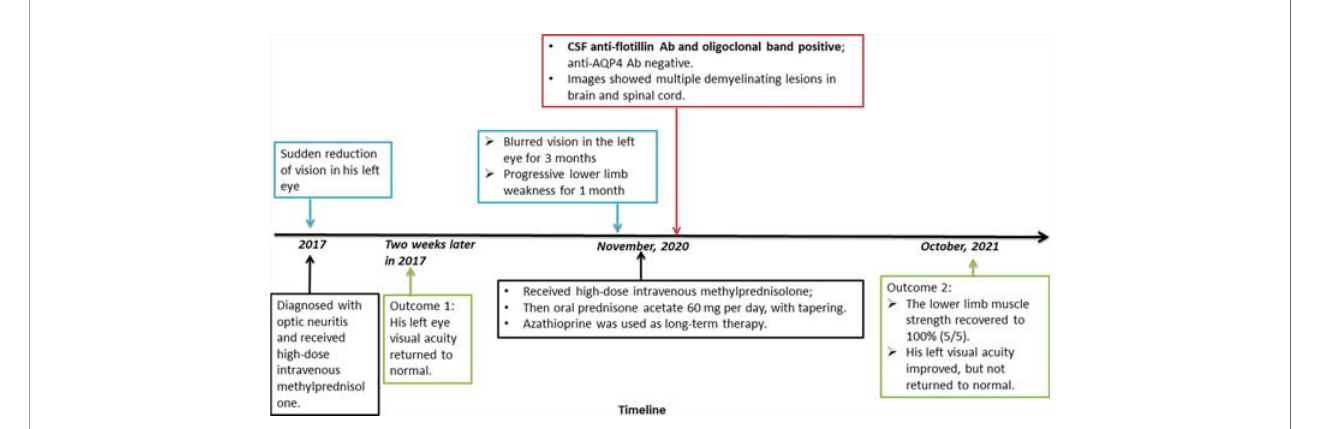
FIGURE 1 | Timeline of the